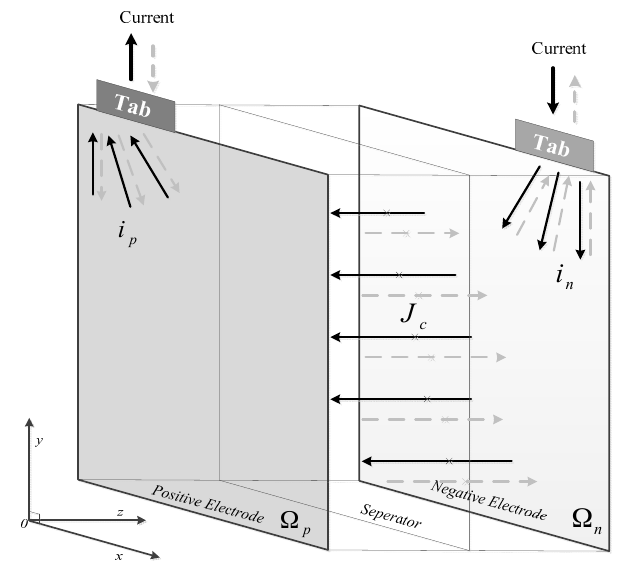
Figure 1. Schematic diagram of the current flow in the parallel plate electrodes. — for discharge; and --- for charge.